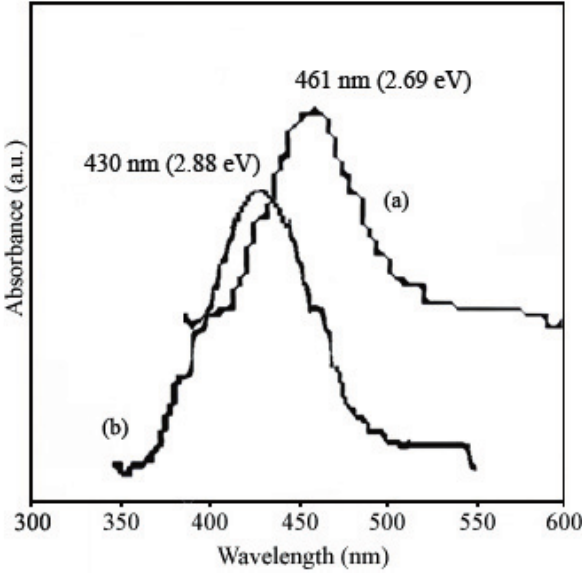
Figure 5. PL spectra of the prepared: (a) CdS nanoparticles via decomposition of precursor and (b) CdS flower-like nanoparticles via hydrothermal